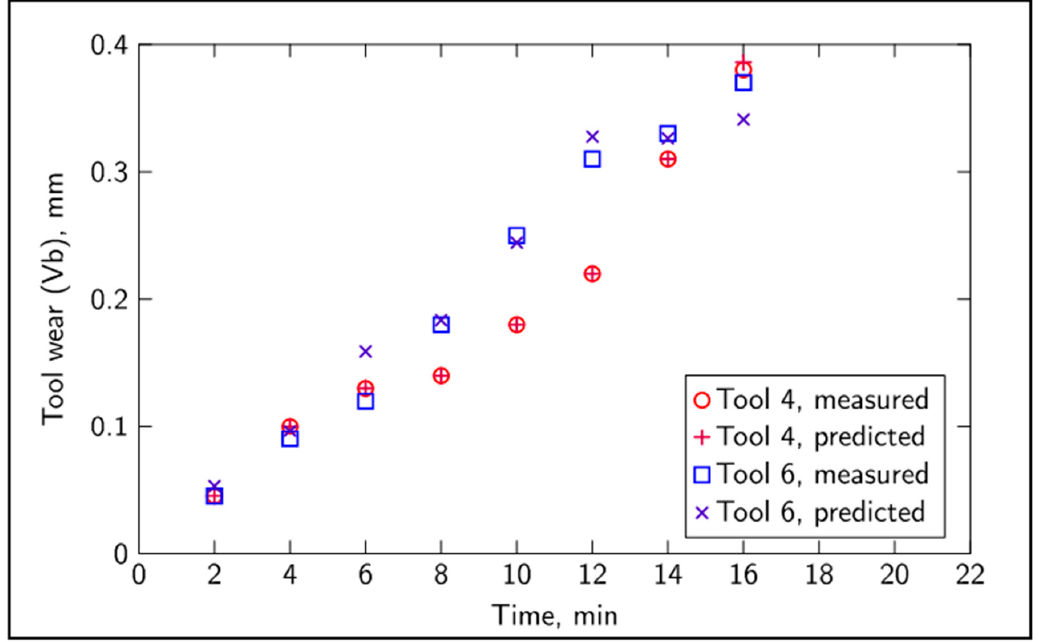
Figure 7. Classification performance on previously seen data (Tool 4) and unseen data (Tool 6). Sensors 2020 , 20 , x FOR PEER REVIEW